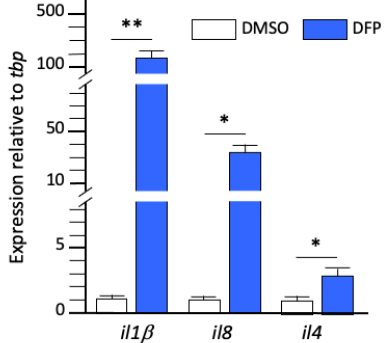
Figure 4. DFP exposure induced massive brain inflammation. Expression levels of transcripts encoding cytokines Il1 β , Il8 , and Il4 , relative to that of reference tbp transcripts, in dissected brain RNAs from larvae exposed for 6 h to 15 µ M DFP or DMSO (in each condition, N = 5 samples, n = 10 brains/sample). Error bars on all graphs represent the standard error of the mean (SEM). Statistics: *, p < 0.05; **, p < 0.01; n.s., not significant.